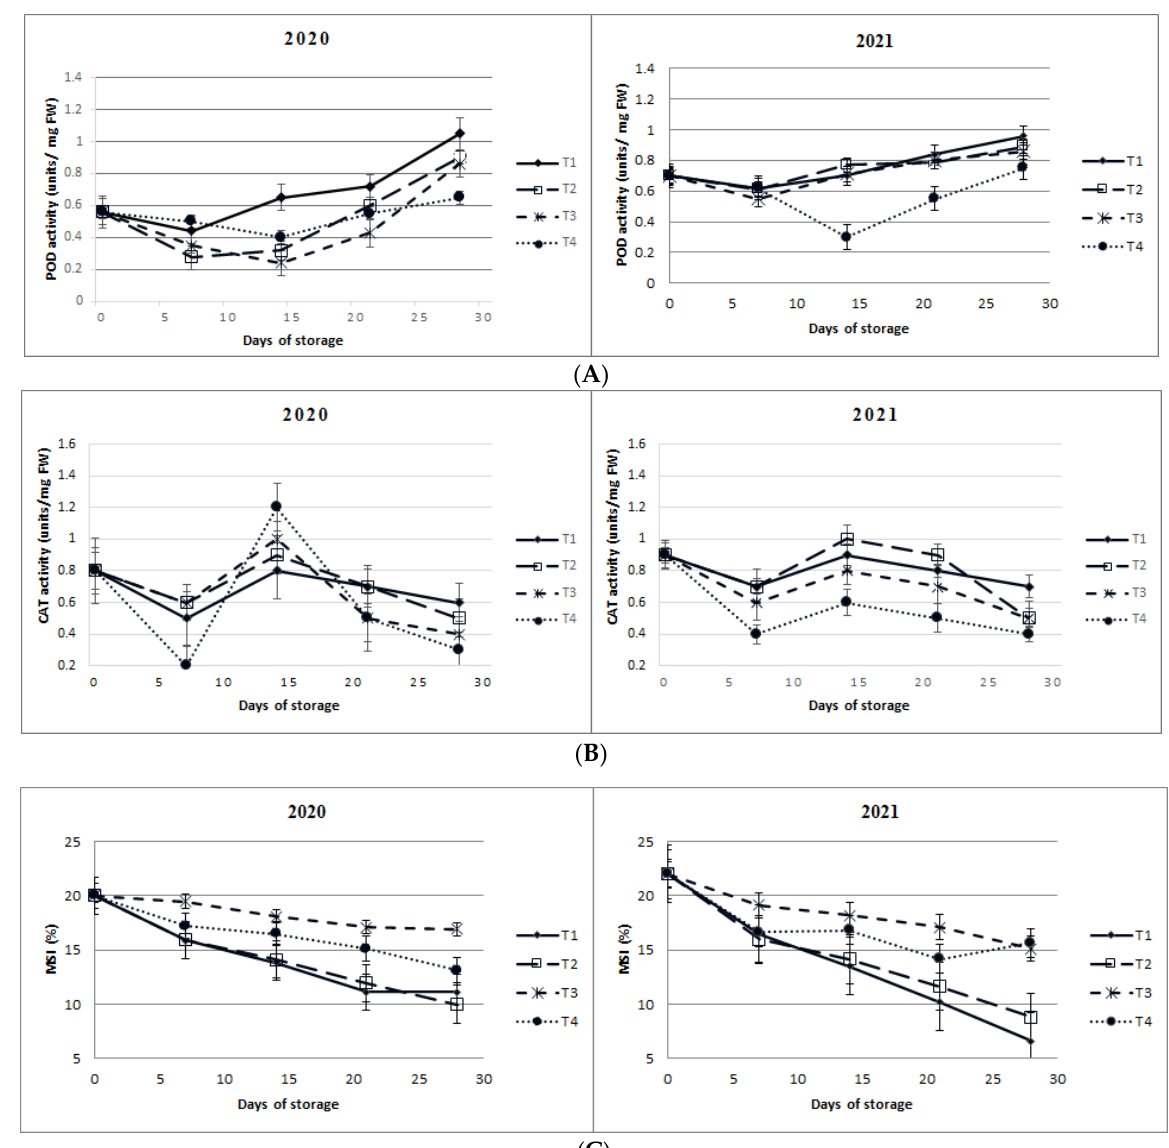
Figure 4. Effect of hot water treatment and chitosan coating on peroxidase (POD) activity ( A ), catalase (CAT) activity ( B ), and membrane stability index (MSI) percentage ( C ) of mango fruits during storage at 13 ± 0.5 °C and 85–90% relative humidity (RH) for 28 days during 2020 and 2021 seasons. Values are means ± SE from three replicates. Statistical analysis was performed using LSD test.